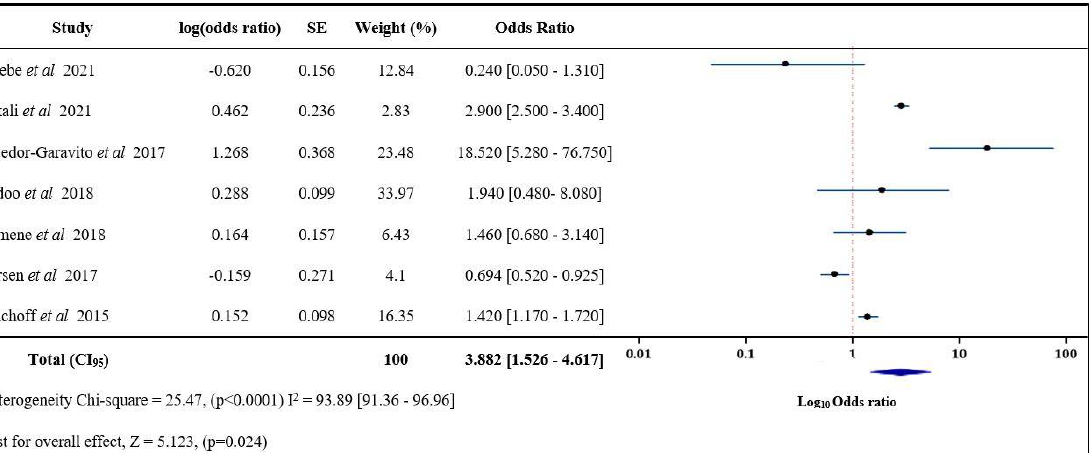
Figure 3. The risk of malaria infection in a neighbor of an index case compared with an index case household member [24, 26, 33, 36-38, 41, 43, 49, 53, 54, 58, 64]. 3.3.3. Risk of Malaria Infection Living with an Index Case < 5 Years Old The risk of malaria infection in an individual living with an index case < 5 years old according to the pooled fixed effect model ranged between 0.240 and 18.520. The aver- age risk of infection was 3.882 (1.526 – 4.617) according to the pool of seven studies that were statistically significant ( p = 0.003) (Figure 4). According to the pooled results, high